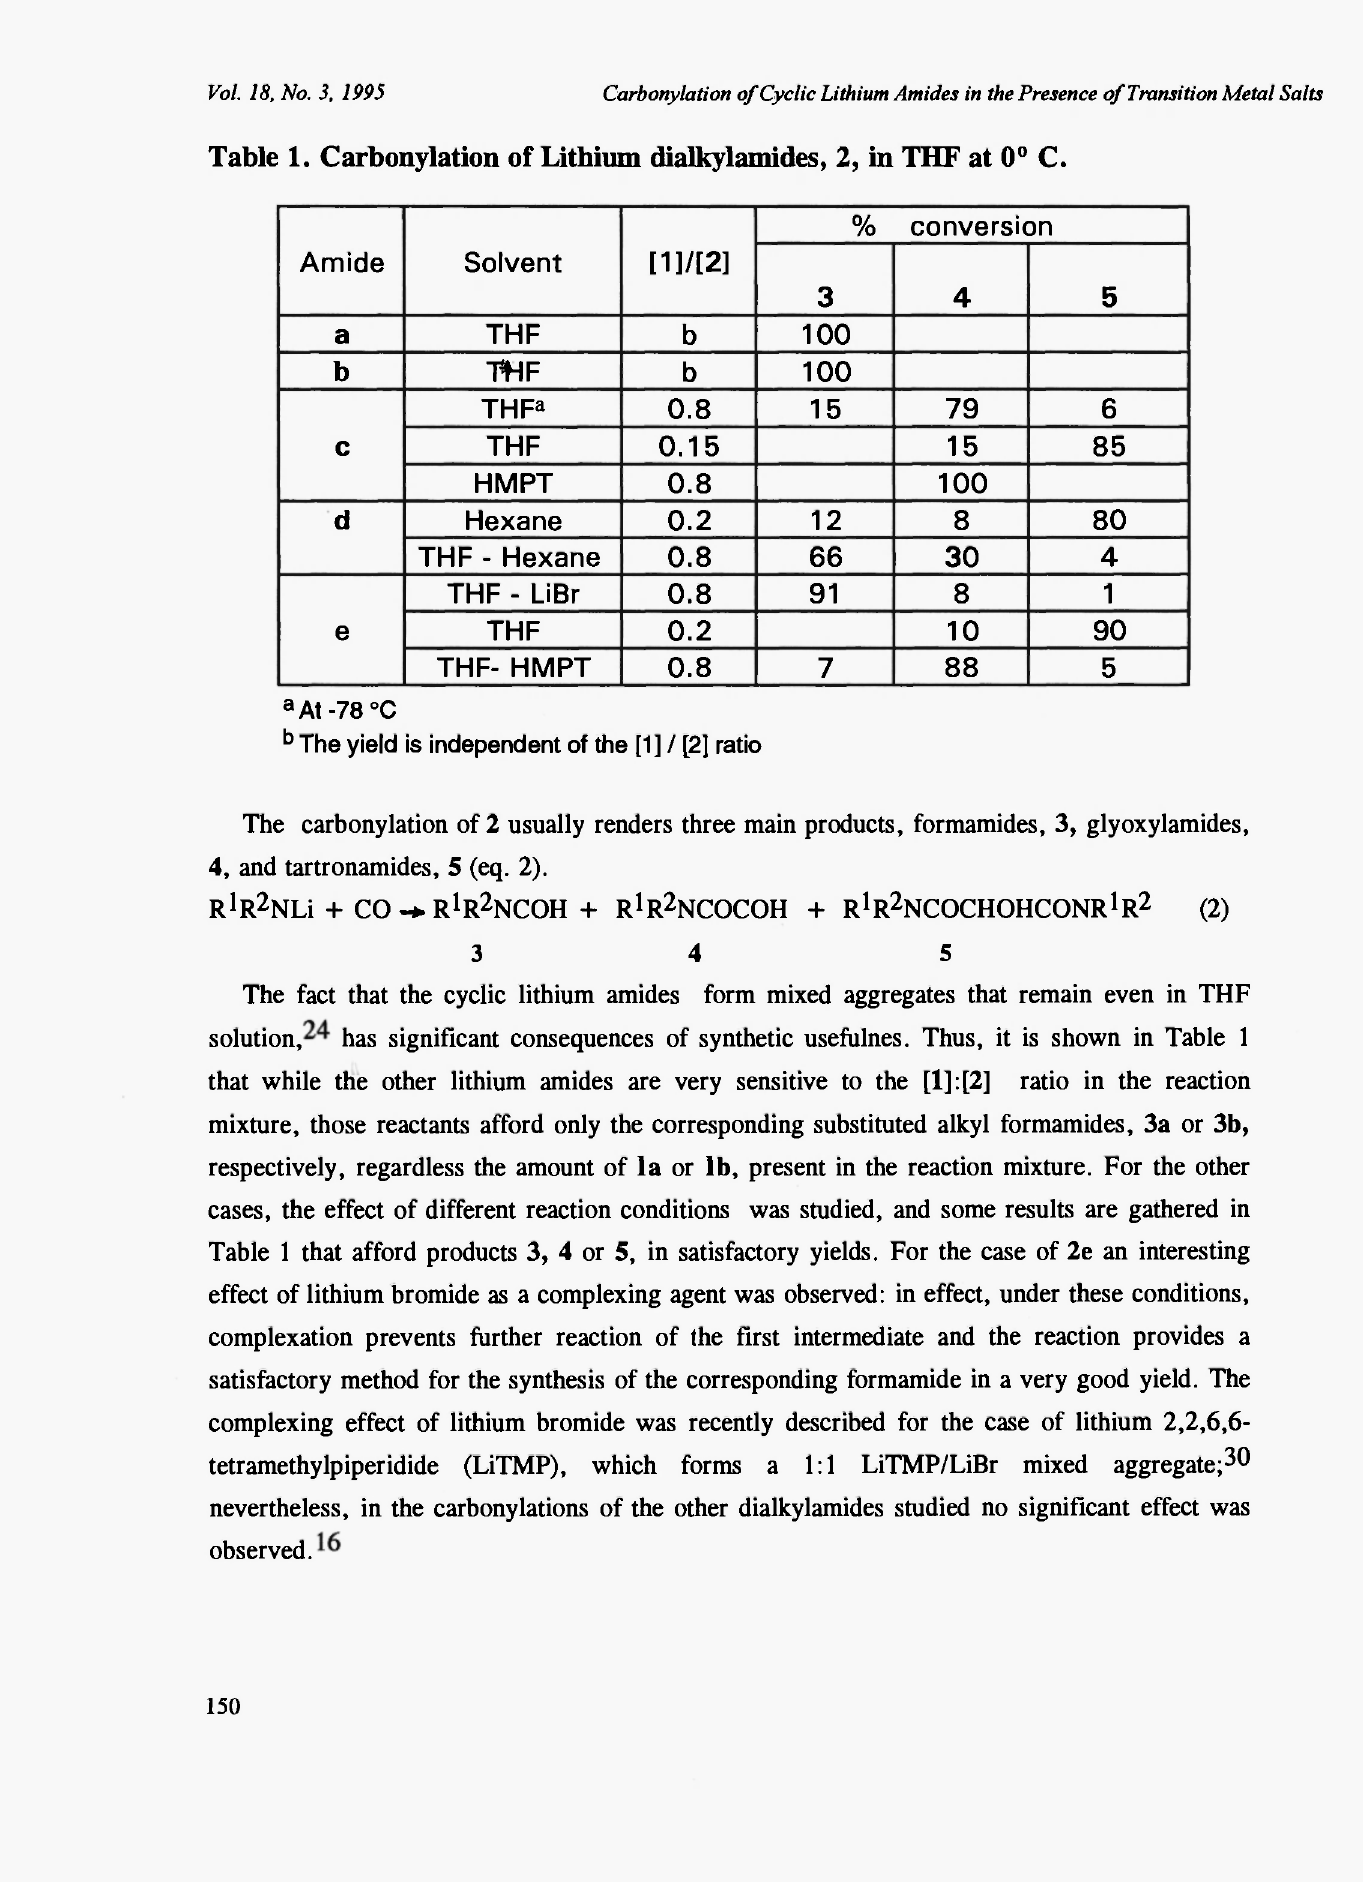
Table 1. Carbonylation of Lithium dialkylamides, 2, in THF at 0° C.